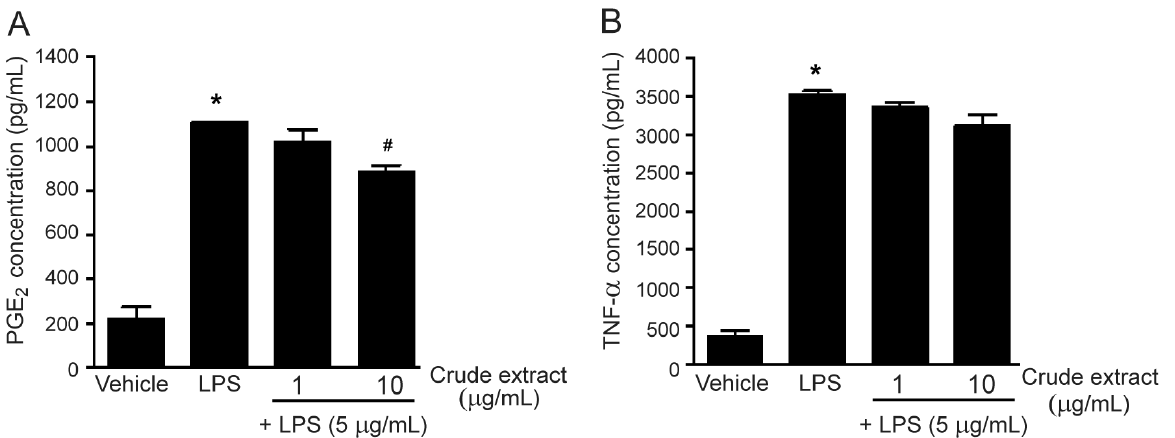
Figure 3. Effects of the methanol extract of M. sirikitiae leaves on LPS-induced PGE 2 and TNF- α secretion in RAW 264.7 cells; Serum-starved cells were pretreated with various concentrations of 0, 1, and 10 µ g/mL of crude methanol extract for 3 h, and then stimulated with LPS (5 µ g/mL) for 24 h at 37 ◦ C. The levels of PGE 2 and TNF- α secreted into the medium were assessed by ELISA assay. The PGE 2 ( A ) and TNF- α ( B ) levels were quantified using a standard curve and expressed as the mean ± SEM ( n = 3). *, p < 0.05 vs. vehicle; #, p < 0.05 vs. LPS.